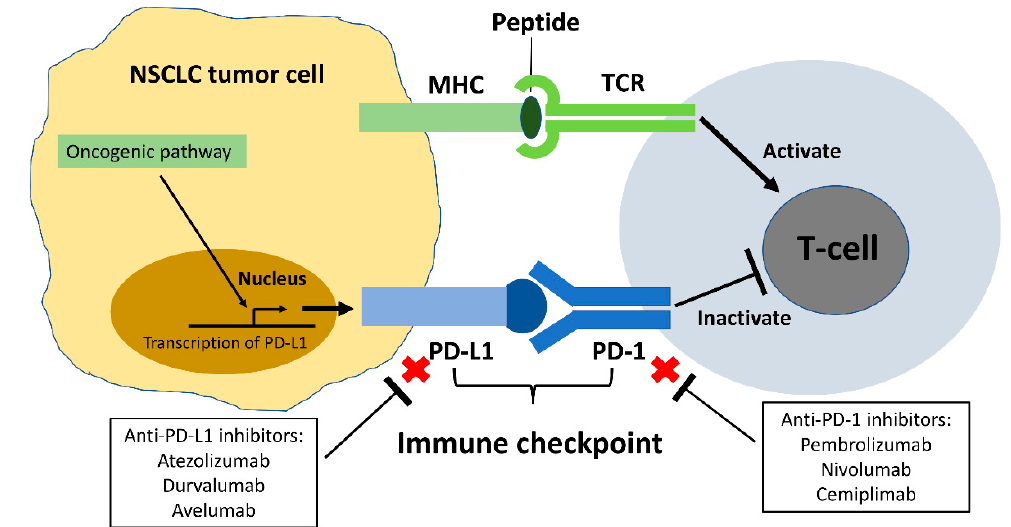
Figure 2. PD-1 / PD-L1 immune checkpoint in NSCLC. In NSCLC cells, the binding of PD-1 and PD-L1 promotes T-cell tolerance and escape from host immunity. Immunotherapy targeting the PD-1 / PD-L1 immune checkpoints has used to treat metastatic NSCLC. Pembrolizumab, nivolumab and cemiplimab are anti-PD-1 inhibitors, and atezolizumab, durvalumab and avelumab are anti-PD-L1 inhibitors.